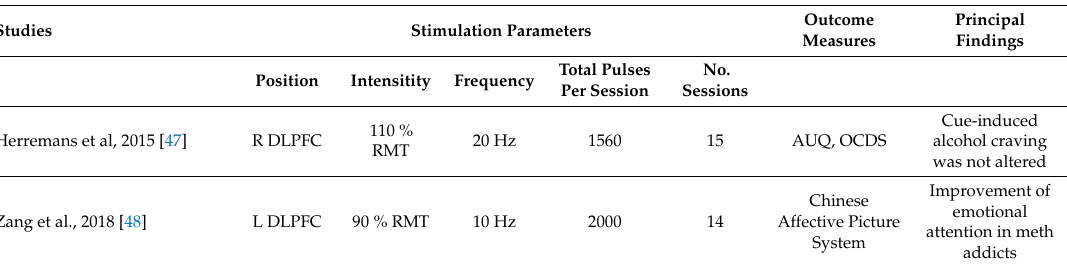
Table legend: R = right; L = left; DLPFC = dorsolateral prefrontal cortex; MT = motor threshold; CANTAB = Cambridge Neuropsychological Test Automated Battery; RVP = Rapid Visual Processing; VAS = Visual Analogue Scale; ZVT = Zahlen-Verbindungs-Test; SKT = Syndrom-Kurztest; BDI = Beck depression Inventory; SART = Sustained Attention to response task; CDR System = Cognitive Drug Research Computerized Assessment System; TAP = Test of Attentional Performance; SANS = Scale for the Assessment of Negative Symptoms; PANAS = Positive and Negative Affect Schedule; TOVA = Test of Variables of Attention; CAARS = Conners’ Adult ADAH Rating Scale; BEHAVE-AD = Behavioral Pathology in Alzheimer’s Rating Scale; ADAS-Cog = Alzheimer’s Disease Assessment Scale-Cognitive; ABC = Aberrant Behavior Checklist; SCR = Social Responsiveness Scale; RBS = Repetitive Behavior Scale; AUQ = Alcohol Urge Questionnaire; OCDS = Obsessive Compulsive Drinking Scale; ERP = event-related potentials; ↑ = enhancement; ↓ =